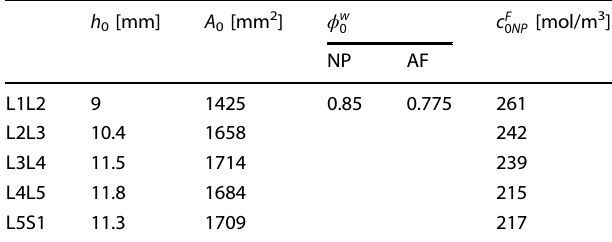
Table 2. Parameters for lumbar disc height ( h 0 ), cross-sectional area ( A